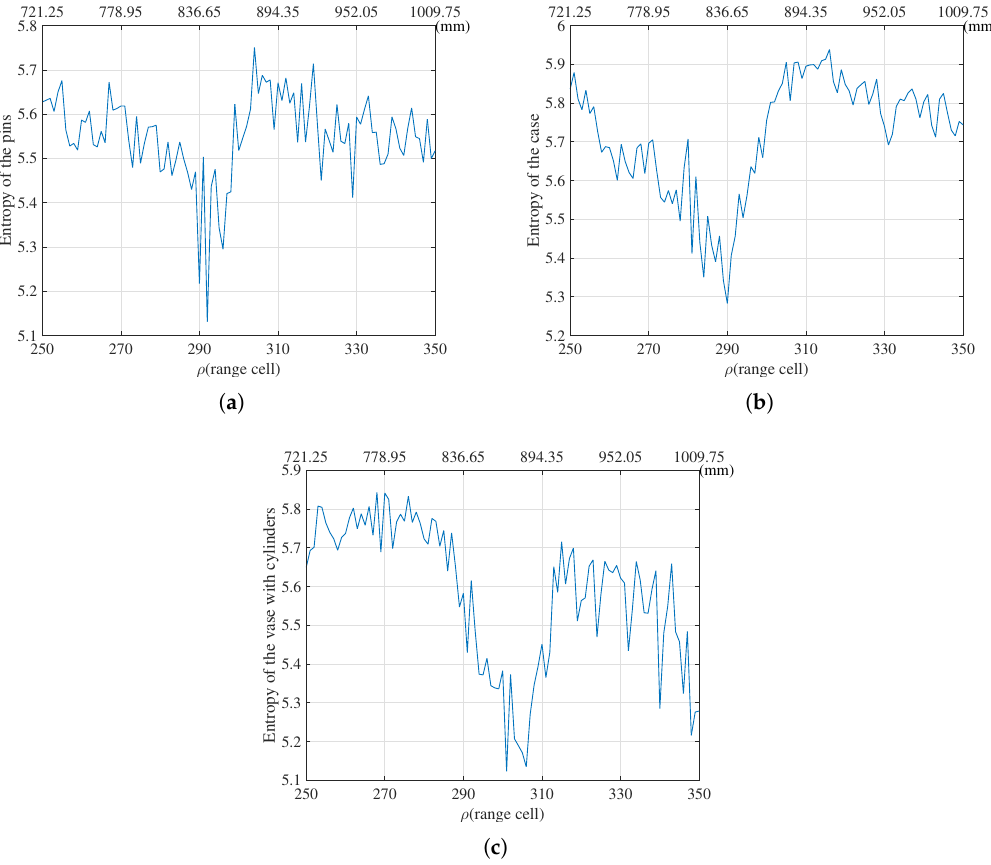
Figure 15. In the near-field, the entropy of the compressed images with respect to ρ . ( a ) The entropy with respect to ρ from the compressed radar image of the pins. The minimum peak at 292th range cell was used; ( b ) The entropy with respect to ρ from the compressed radar image of the metal pen and pencil case. The minimum peak at 290th range cell was used; ( c ) The entropy with respect to ρ from the compressed radar image of the cylindrical pencil vase with metal cylinders. The minimum peak was clear at 301th range cell.